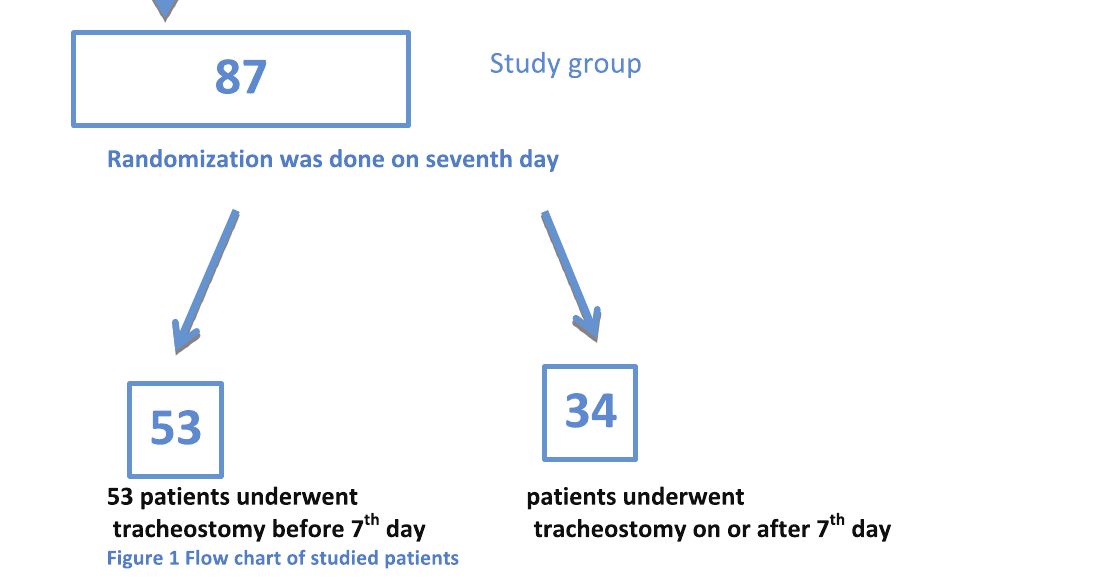
Flow chart of studied